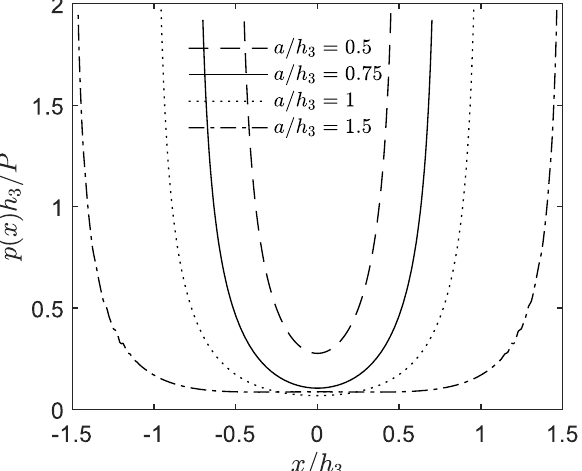
Crystals 2022 , 12 , x FOR PEER REVIEW Figure 2. The effect of a non–dimensionalized indenter size a / h 3 on the distribution of non– Figure 2. The effect of a non – dimensionalized indenter size dimensionalized stationary contact pressure ( µ 03 = µ 1 , h 2 = h 3 , β 2 h 2 = β 3 h 3 = 1 ) . mensionalized stationary contact pressure (